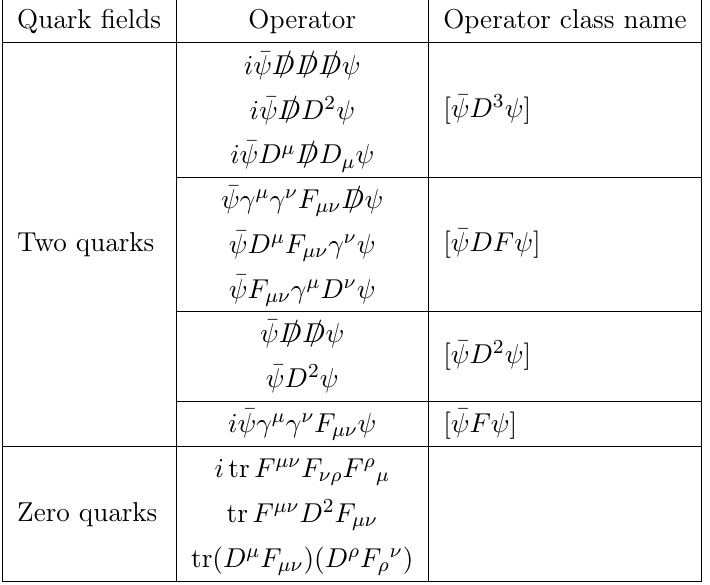
Table 1 . Table of potential higher dimension operators in the 6 dimensional QCD effective La- grangian. We have ignored four quark operators, which are not relevant for t (cid:22) t + gluons scattering at this order, and operators related to those in our table by integration-by-parts or Hermitian conjugation. We have also imposed the parity symmetry of